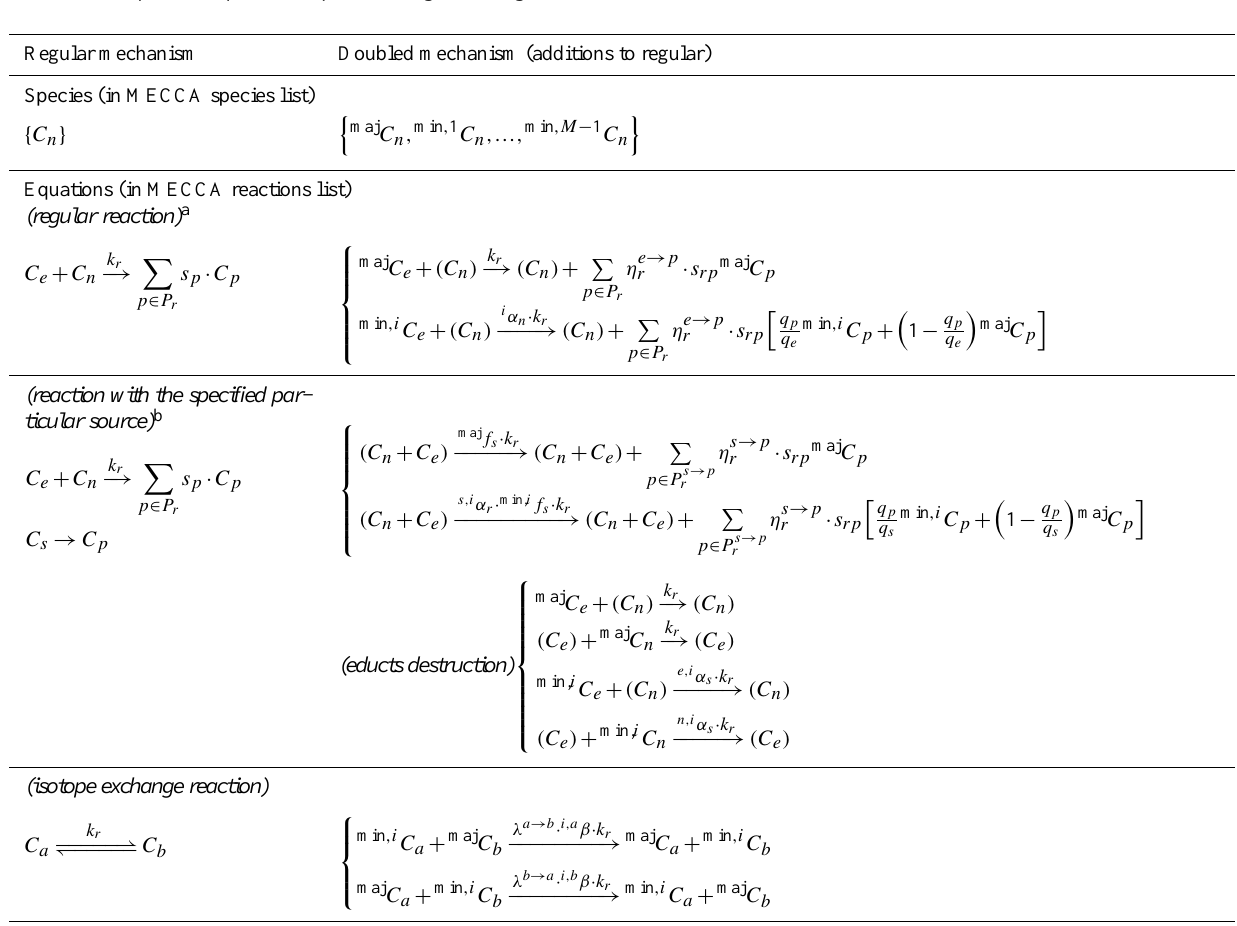
Table 1a. Example for implicit isotopic doubling of the regular chemical